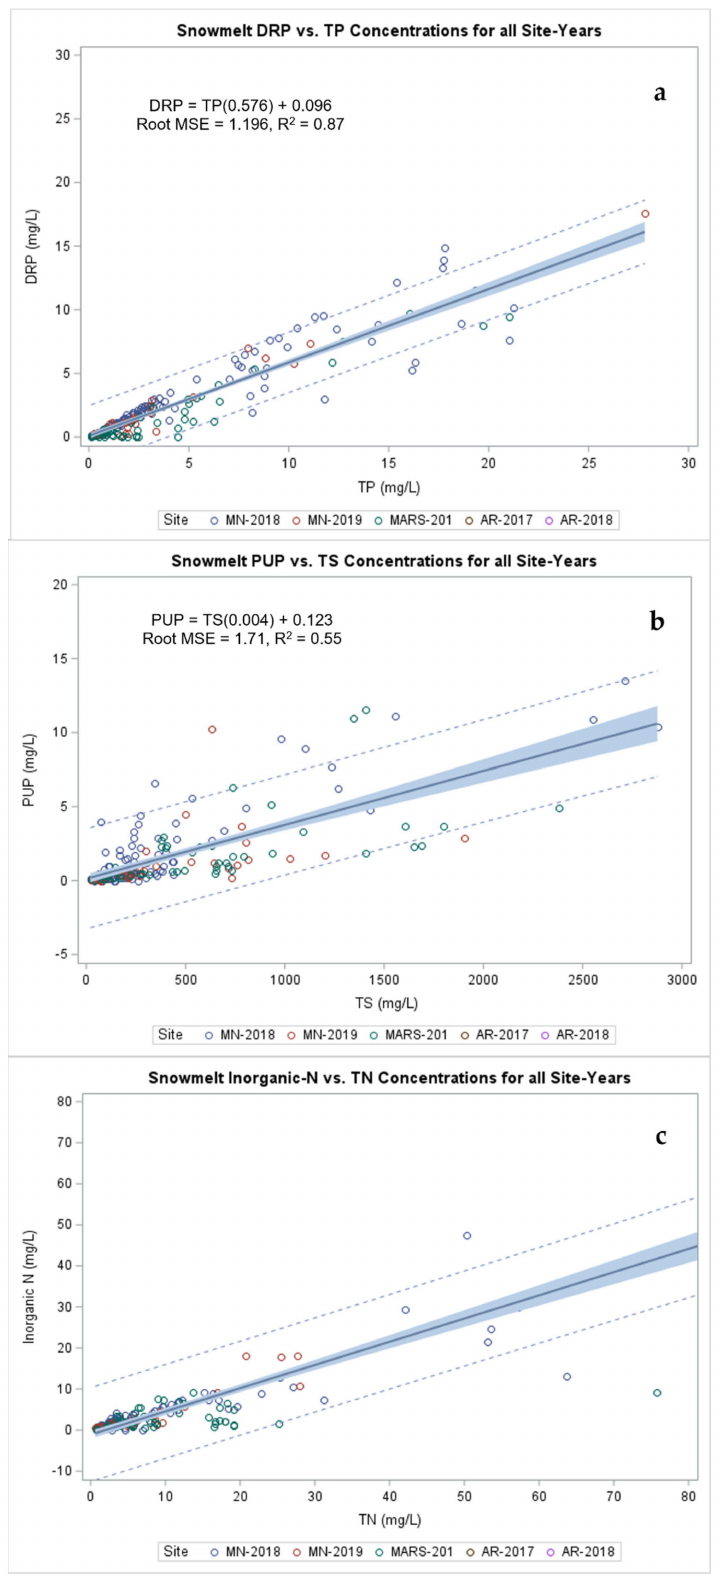
Figure 10. Relationships between total phosphorus and dissolved reactive phosphorus (DRP) ( a ), particulate/unreactive P (PUP) and total solids (TS) ( b ), and inorganic and total nitrogen (TN) ( c ), and for all site-years with available